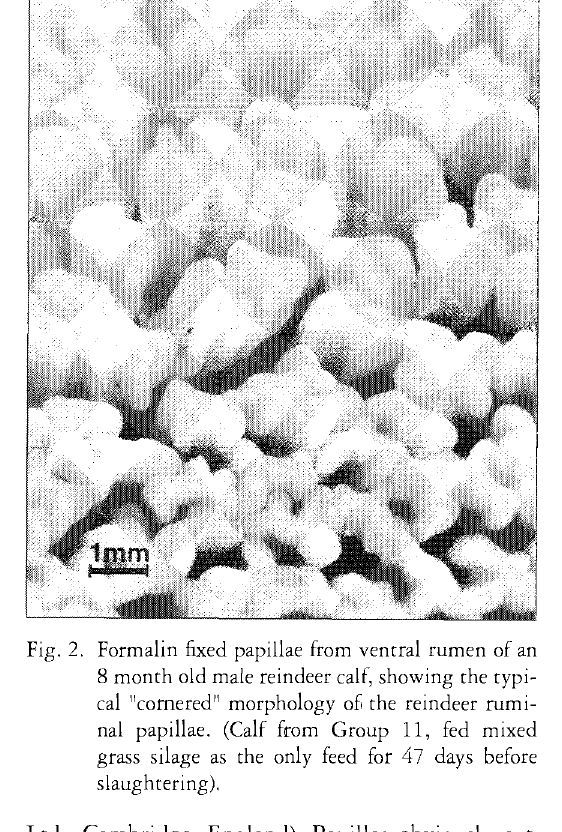
Fig. 2. Formalin fixed papillae from ventral rumen of an 8 month old male reindeer calf, showing the typi cal "cornered" morphology of the reindeer rumi- nal papillae. (Calf from Group 11, fed mixed grass silage as the only feed for 47 days before slaughtering).